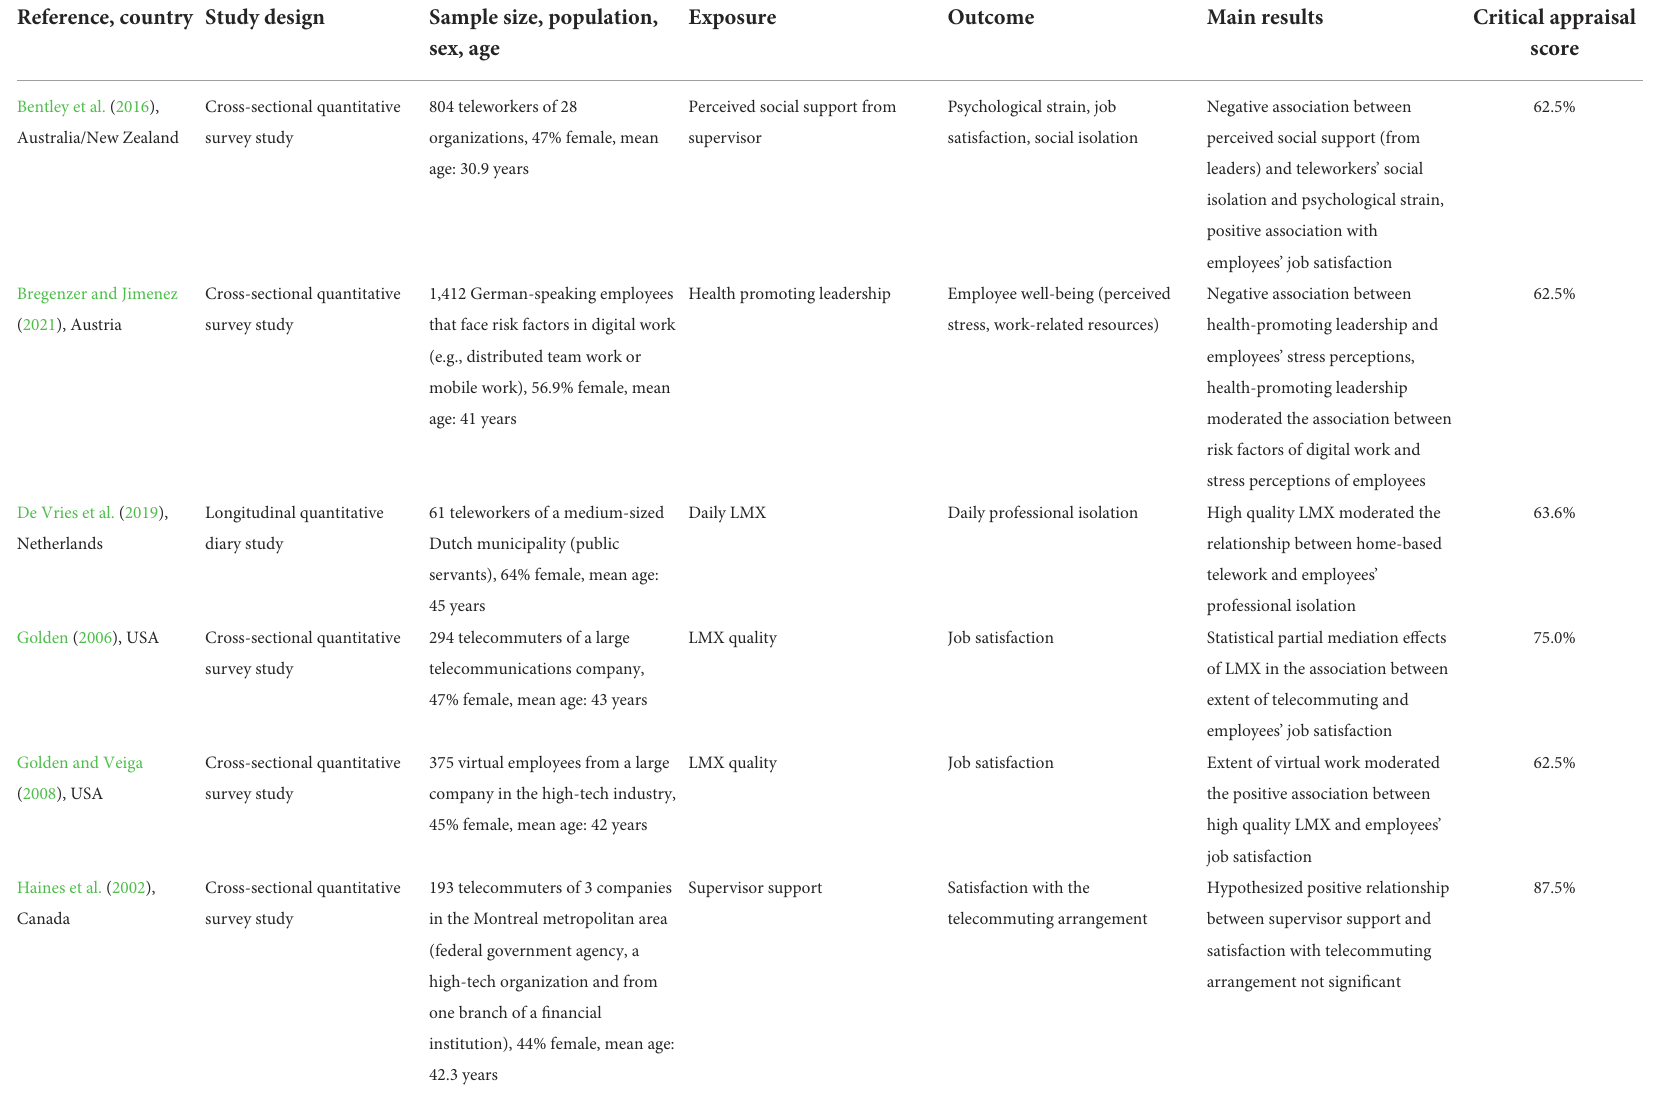
TABLE 3 Study characteristics ( n =